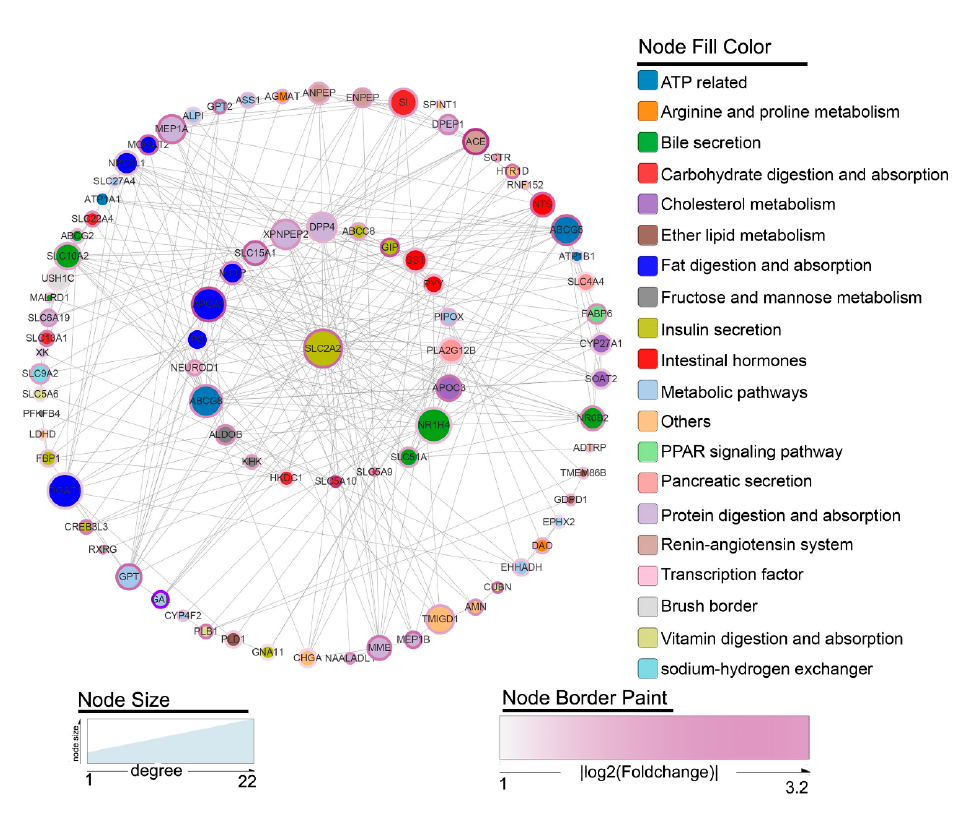
Figure 5. Protein-protein interaction (PPI) network constructed by the Search Tool for the Retrieval of Interacting Genes (STRING) database for DEGs. The two-level gene network relationship of the hub gene ( SLC2A2 ) with the highest degree as the center. Node size indicates the degree of each gene. Node border color represents the fold change in gene expression. Node color represents the functional classification of the